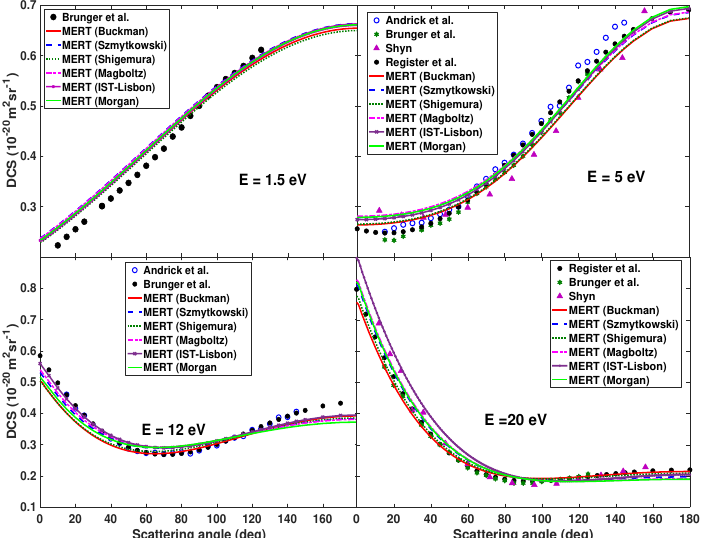
Figure 3. Angular dependencies of MERT − derived differential cross − sections at 1.5, 5, 12, and 20 eV for e − − He scattering. The present results are compared with experimental data of Brunger et al. [41], Andrick et al. [42], Register et al. [43], and Shyn [44]